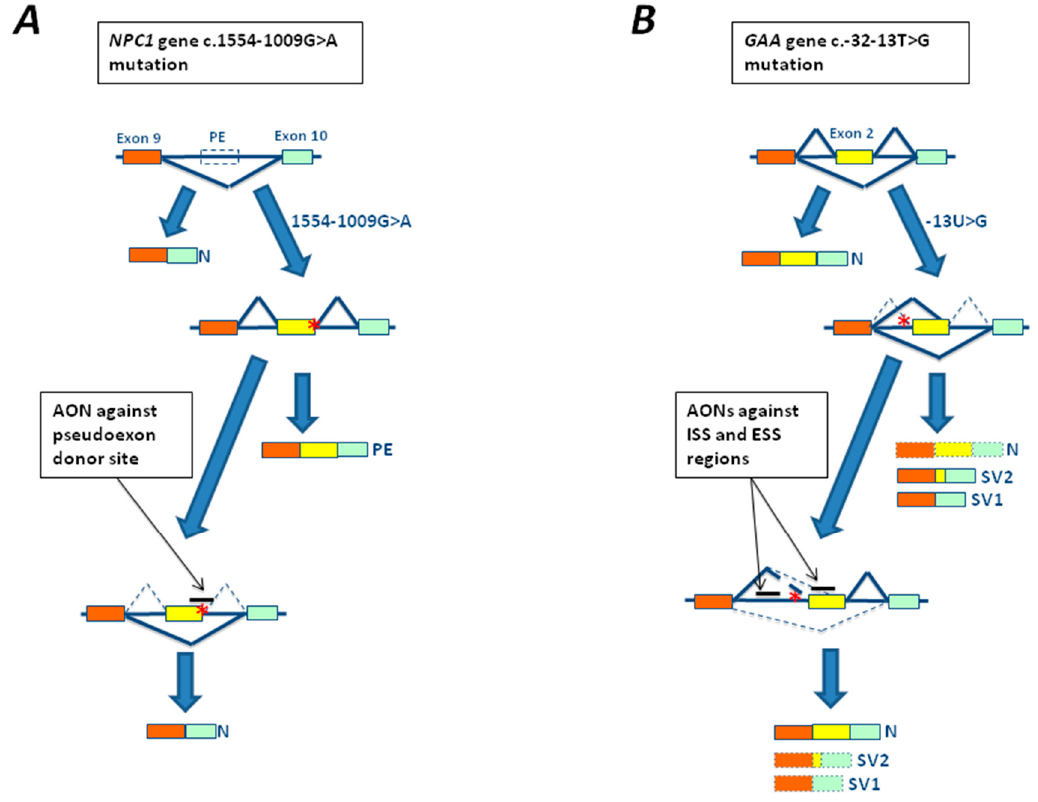
Figure 4. Rescue strategies based on antisense oligonucleotides (AONs) for mutations associated with LSDs. ( A ) Schematic representation of a portion of the Niemann Pick 1 gene ( NPC1 ), where exons 9